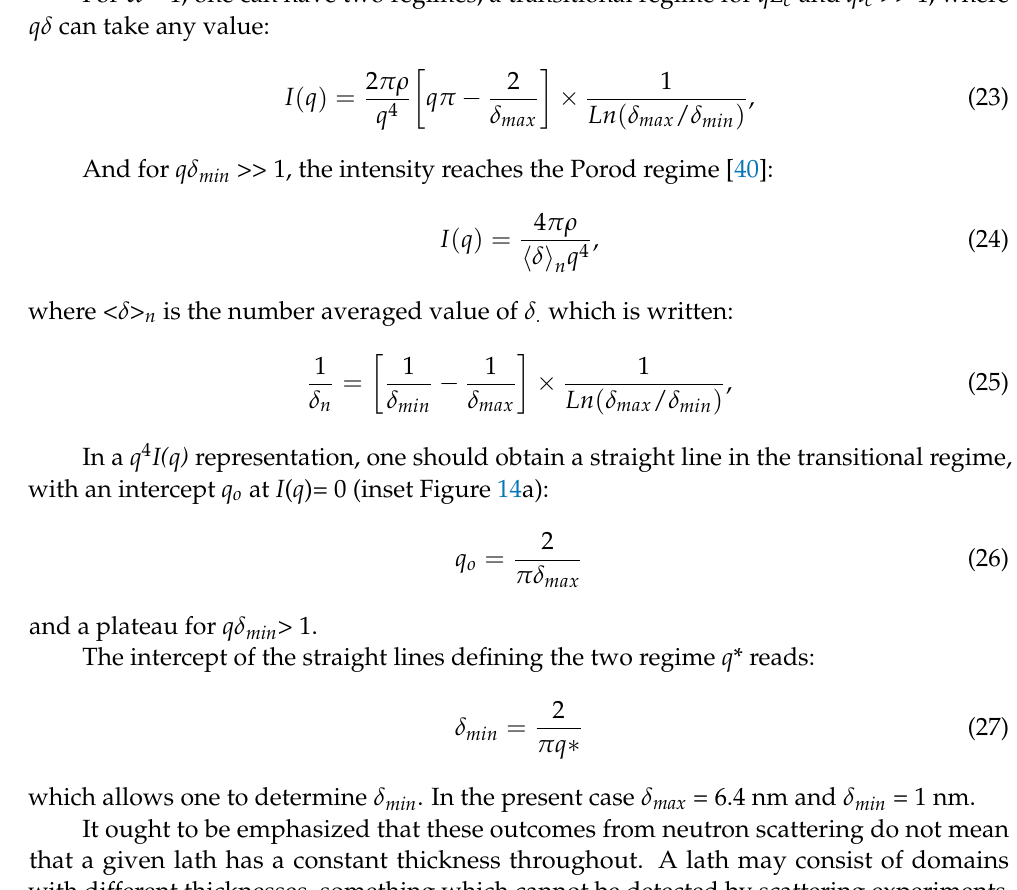
Figure 14. ( a ) Neutron Scattering patterns plotted by means of q 4 I(q) vs. q for propargyl ammonium-based molecule/D 2 O; C= 0.015 g/cm 3 ; regime 1 is a fit with relation 23 while regime 2 is the Porod regime. Inset magnification of regime 1; blue line is a fit of the peak with Equation (16). ( b ) arrangement of the molecules in a chevron-like fashion along the length of the lath [34].